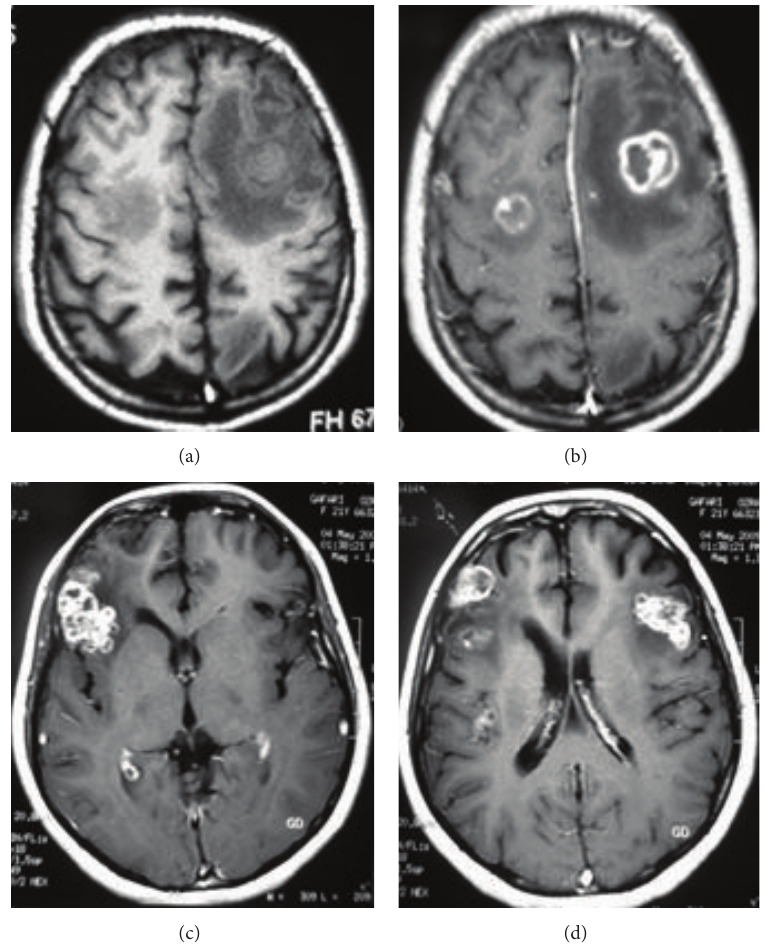
Figure 4: Tuberculous brain abscess. Axial pre- and postcontrast T1-weighted MR images ((a) and (b)) in a 38-year-old male with cognitive and speech disorders show two hypointense lesions in both frontal lobes with peripheral edema, which is severe on left side, and have thick ring-like enhancement (b). (c) and (d) Axial postcontrast T1-weighted MR images in a 22-year-old female with pulmonary miliary tuberculosis and 3-month history of headache, nausea, vomiting, and recent seizure demonstrate bifrontal irregularly enhancing lesions with mild peripheral edema.